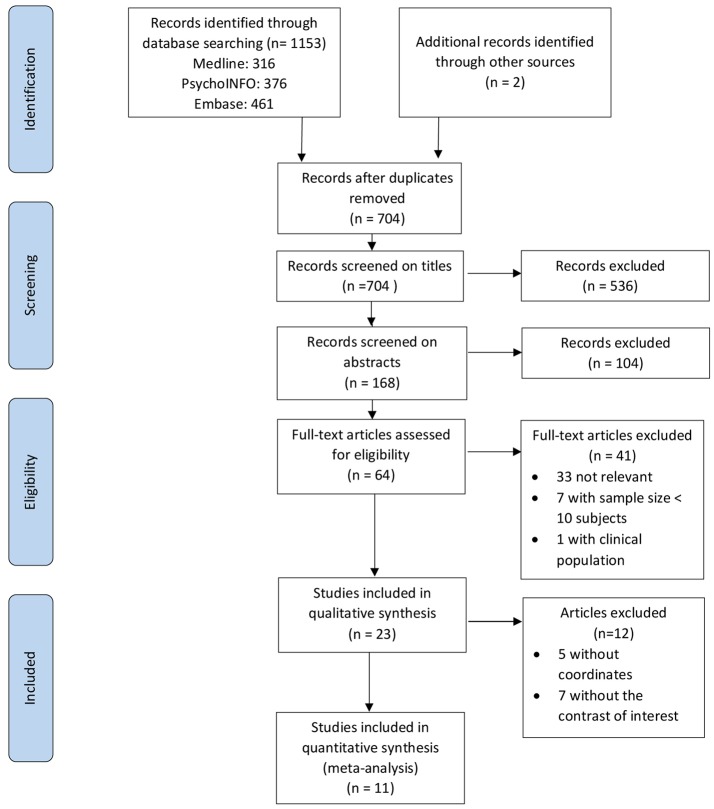
Flowchart of article selection, following PRISMA guidelines. Adapted from Moher et al. (2009).